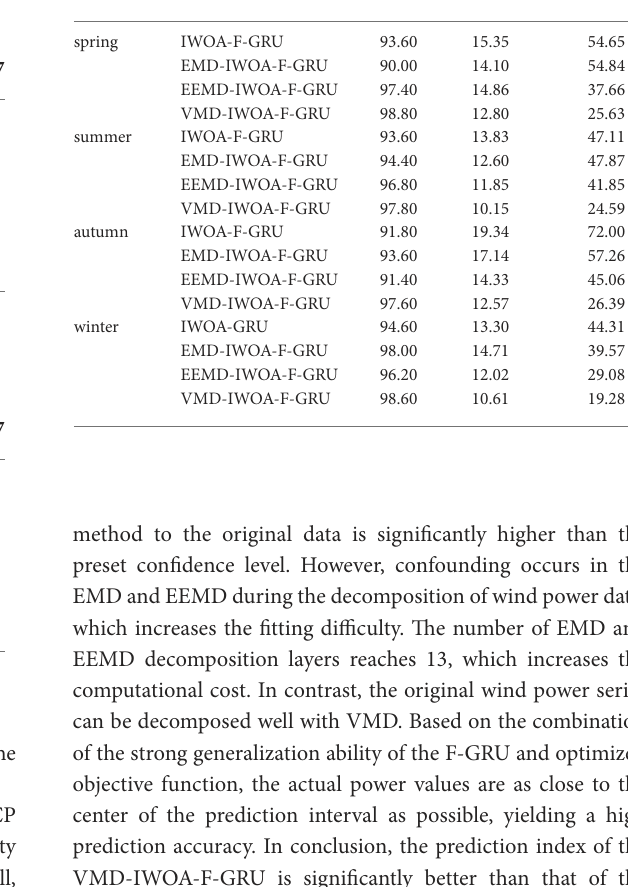
TABLE 3 Center frequencies corresponding to different K values in autumn.